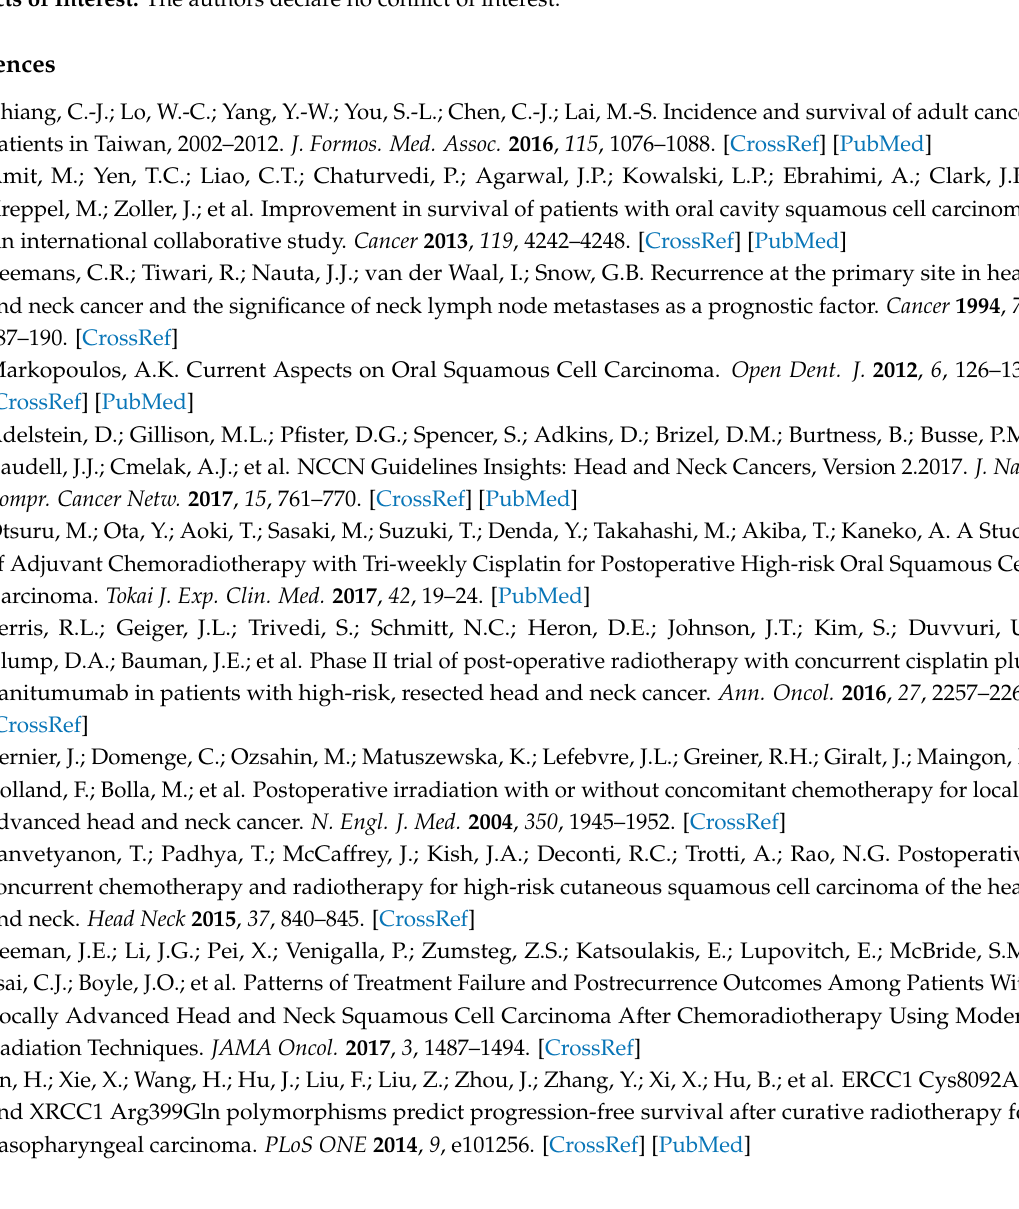
Figure S1: Linkage disequilibrium (LD) analysis among single nucleotide polymorphisms (SNPs) within the same chromosome or gene, Table S1: Frequency distributions of NER polymorphisms by clinicopathological factors, Table S2: Univariate association between NER candidate SNPs and OSCC survival in CCRT treated patients, Table S3: Haplotype analysis of association between NER candidate SNPs and OSCC survival in patients treated with